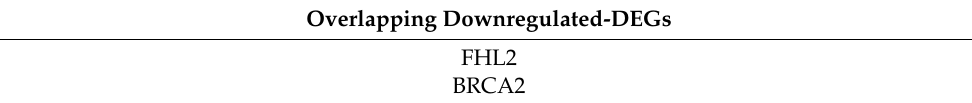
Table 2. Overlapping downregulated DEGs of the four datasets from